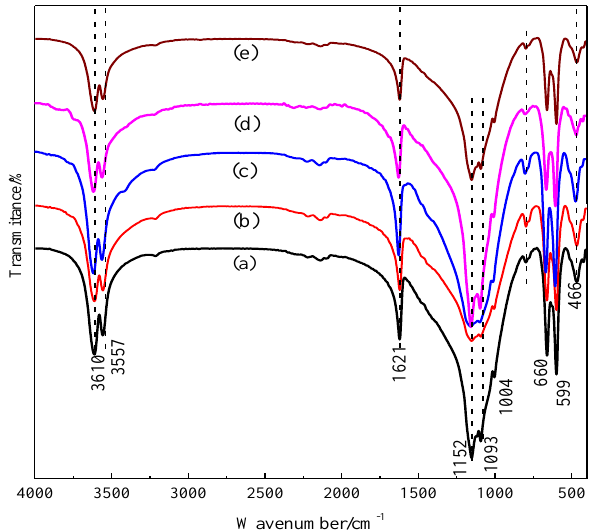
Figure 13. FTIR spectra of CaSO 4 · 0.5H 2 O particles prepared with di ff erent organic acids. ( a ) Blank test; ( b ) PD; ( c ) IPA; ( d ) L-Glu; and ( e ) L-Asn.